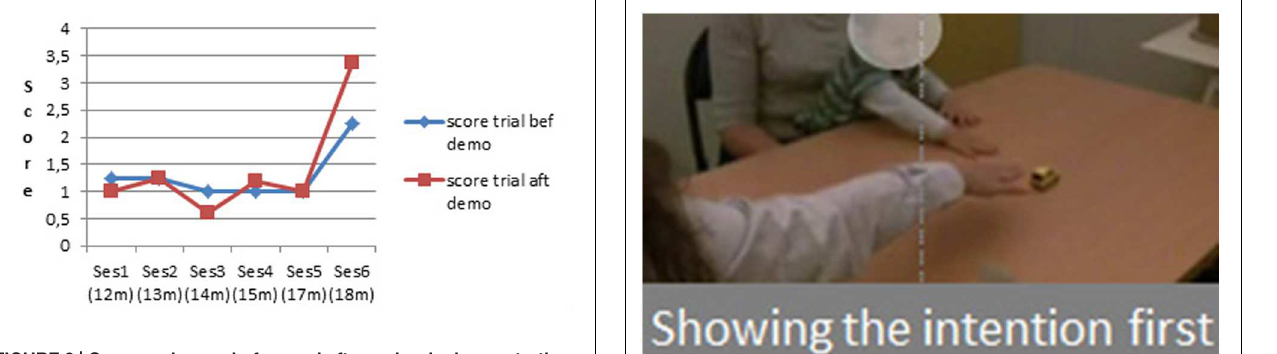
FIGURE 3 | Compared score before and after a classic demonstration (longitudinal study).